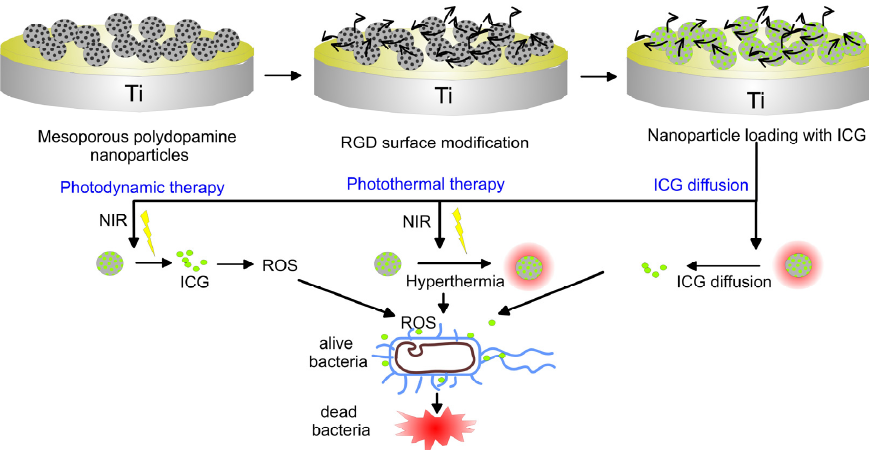
Figure 12. Schematic illustration revealing the coating construction and the elimination process of bacteria biofilm through NIR light triggering remote photodynamic and photothermal synergetic treatment.